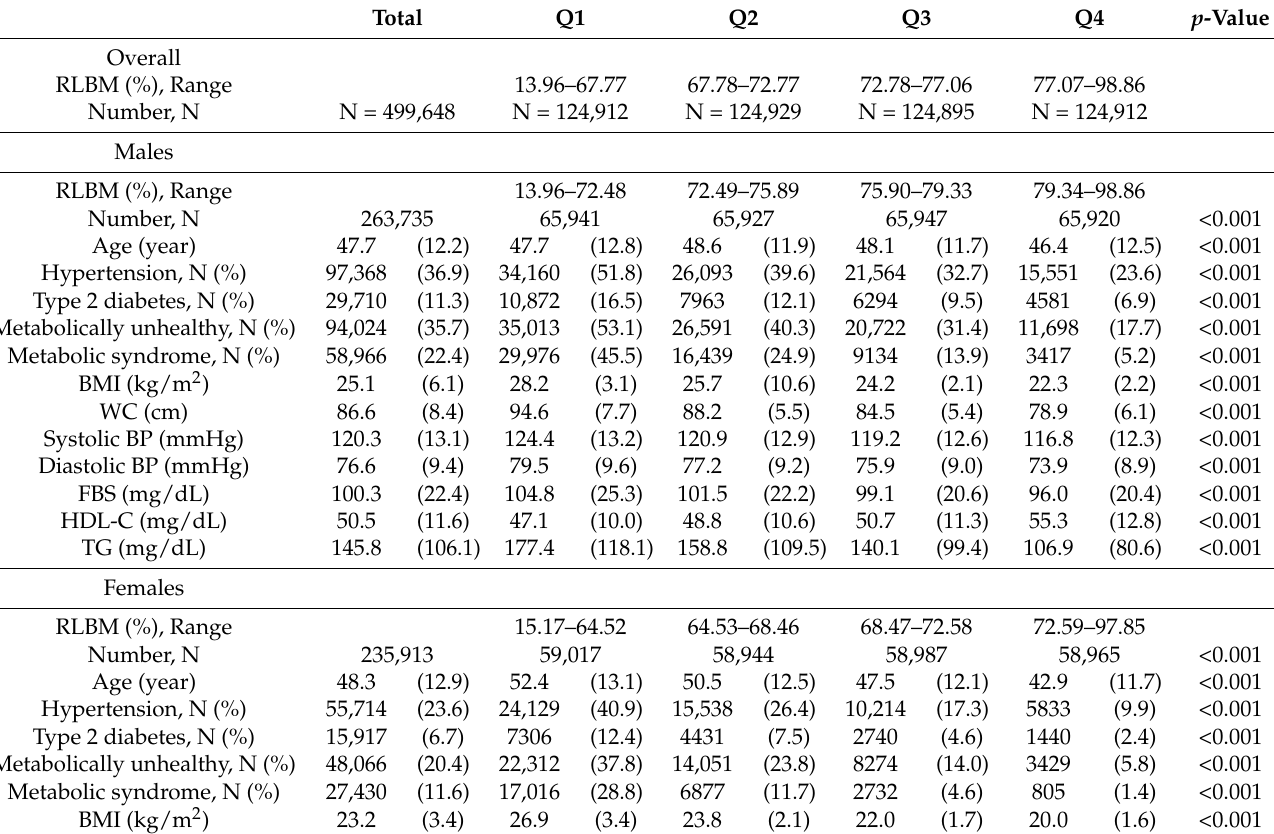
Table 1. Characteristics of subjects by RLBM